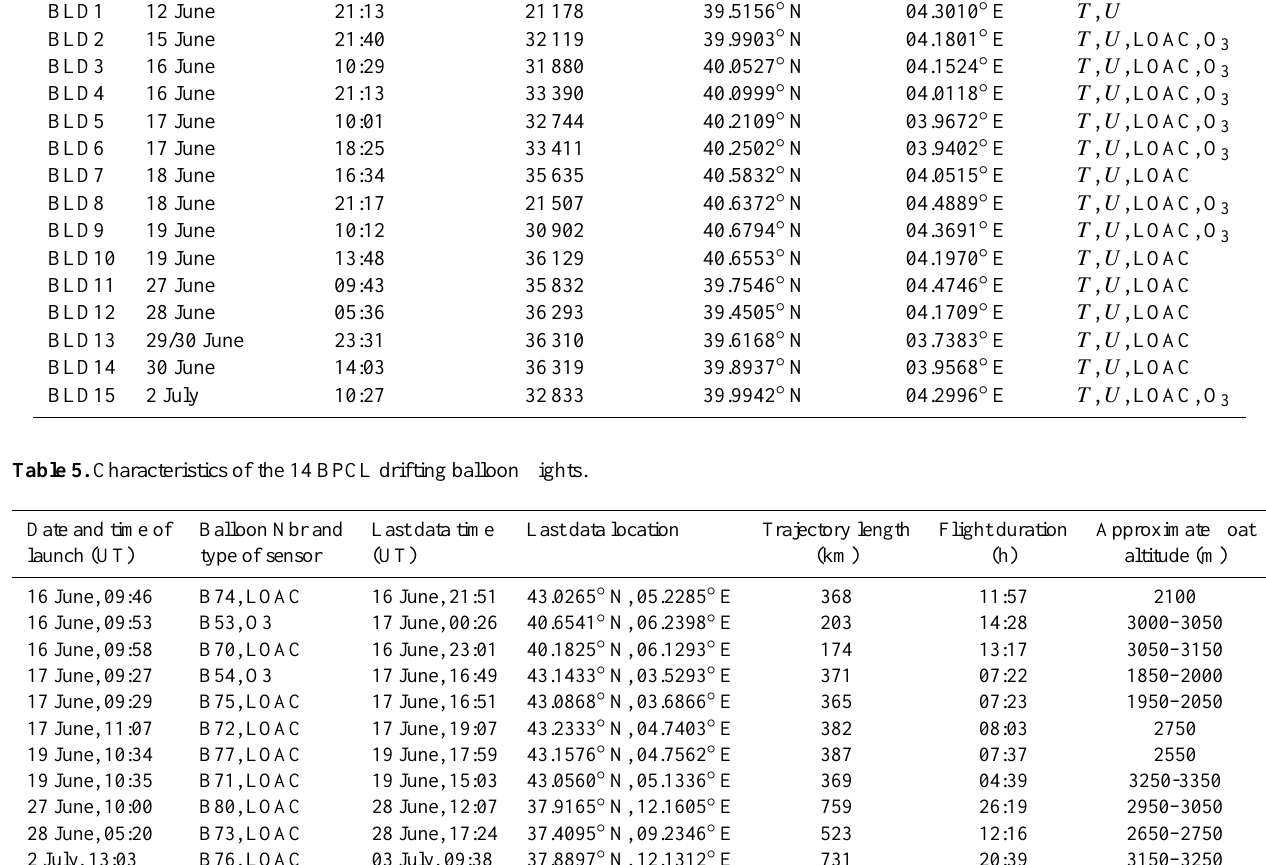
Table 4. Characteristics of the 15 sounding balloon flights from Sant Lluis, Minorca, during the ChArMEx SOP1a/ADRIMED campaign. No.